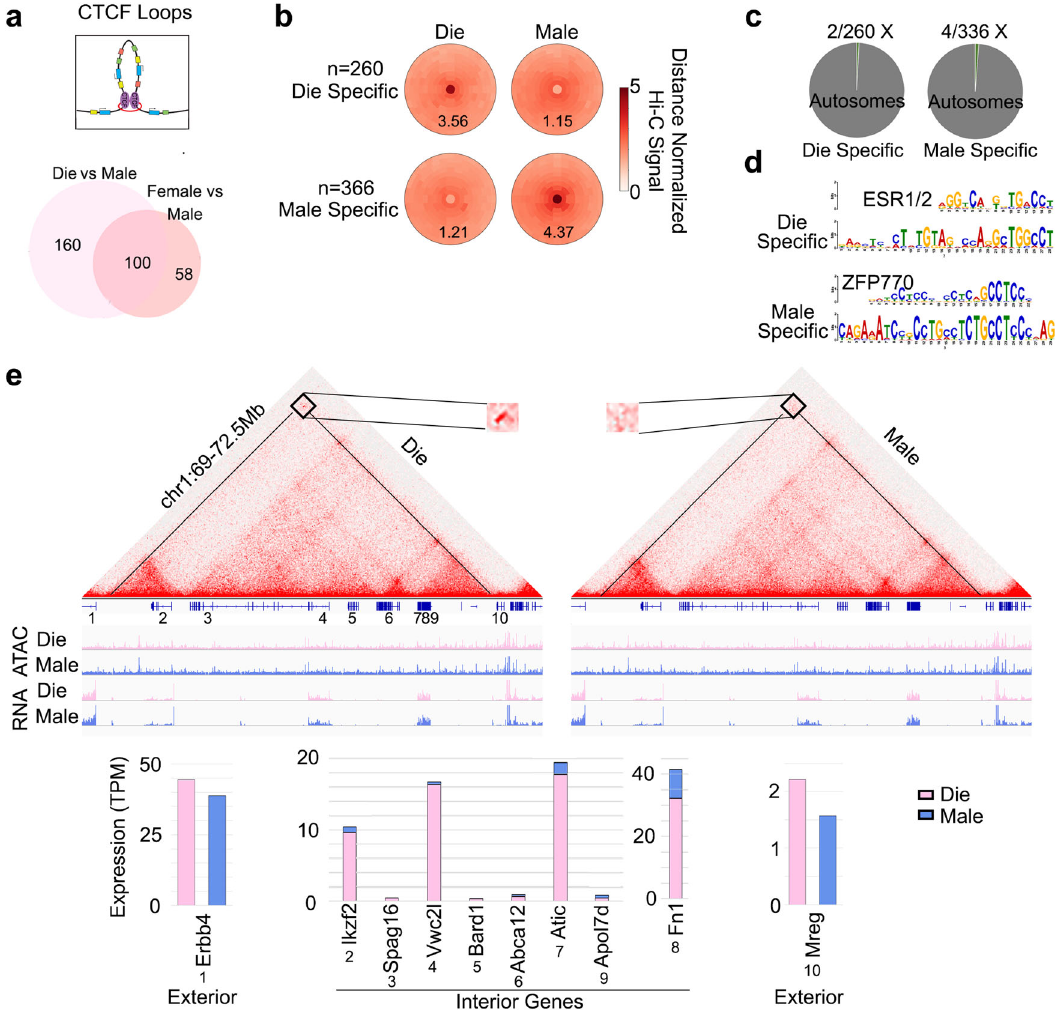
Fig. 3 Sex-speci fi c CTCF loops in vHIP neurons. More sex-speci fi c loops can be called in the Die-Male than in the Mixed Female – Male comparison ( a ). Both Die- and Male-speci fi c loops ( b ) are primarily located on autosomes ( c ). Die-speci fi c loops are enriched for the ER α (ESR1) motif (E value 6.9e − 33) while Male-speci fi c loops are enriched for ZFP770 motif (E value 5.0e − 59) ( d ). Presented is a 3.5 MB loop encompassing eight interior genes and fl anked by two exterior genes ( e ). IGV tracks show merged ATAC-seq and RNA-seq data with the corresponding loops for dioestrus (Die) and males (Male) derived from three biological replicates for each group. Lower panel shows gene expression for each exterior and interior gene. Die, pink; Male,